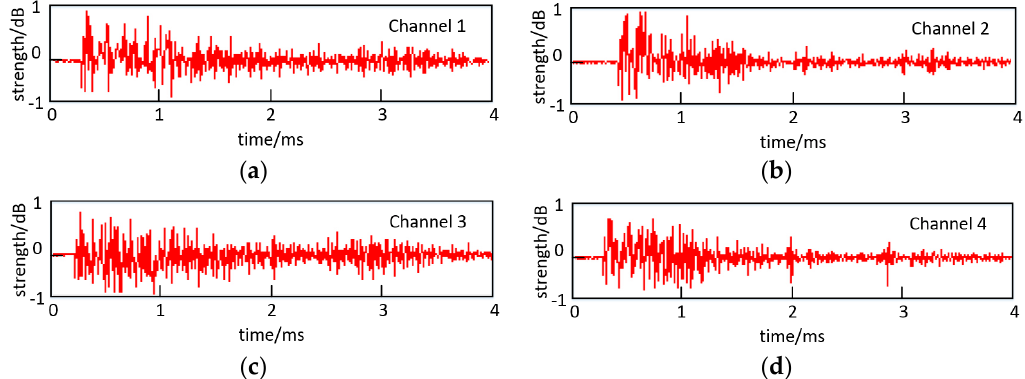
Figure 9. Acoustic signals coupled by the array sensor. Due to space limit and the similarity of 31 signals, four of the 31-recorded signals are shown here. ( a ) channel 1; ( b ) channel 2; ( c ) channel 3; ( d ) channel 4.